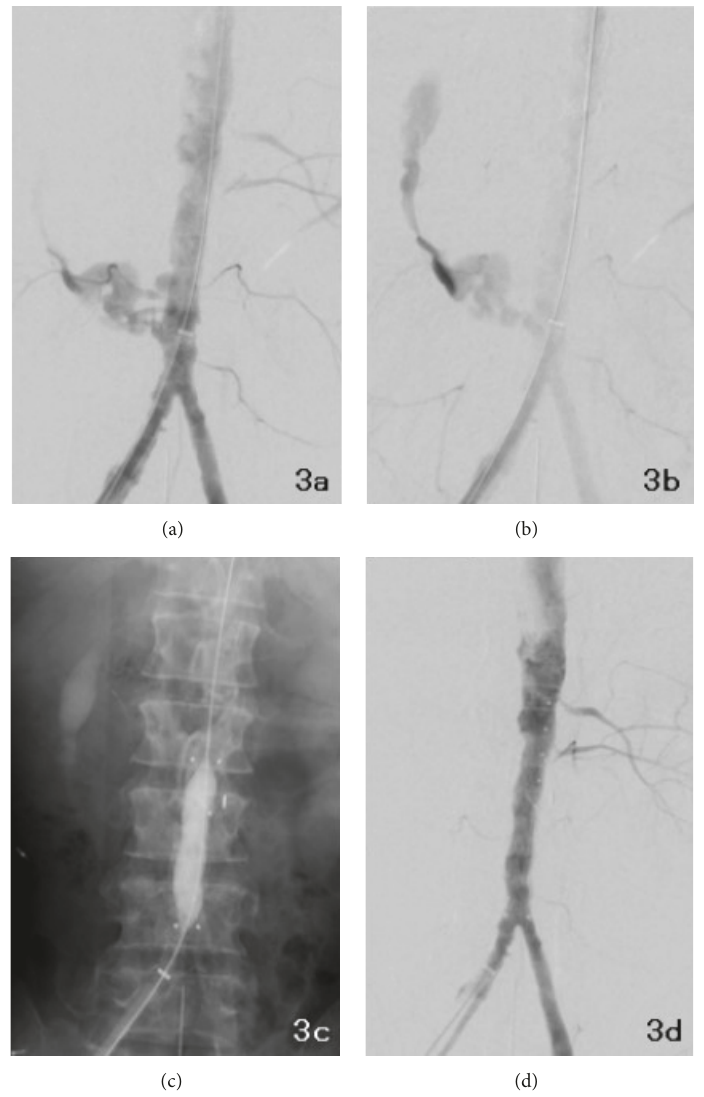
Figure 3: Perioperative digital subtraction angiograms. Extravasation from the right lateral wall of the abdominal aorta (a) and diffusion of the contrast agent along the duodenum (b) were observed. The celiac, superior mesenteric, and right renal arteries were occluded. A covered stent graft was successfully deployed into the abdominal aorta, and a leak at the end of the graft was treated with balloon angioplasty (c). After placement of the endovascular stent graft, aortography showed no extravasation from the right lateral wall of the abdominal aorta